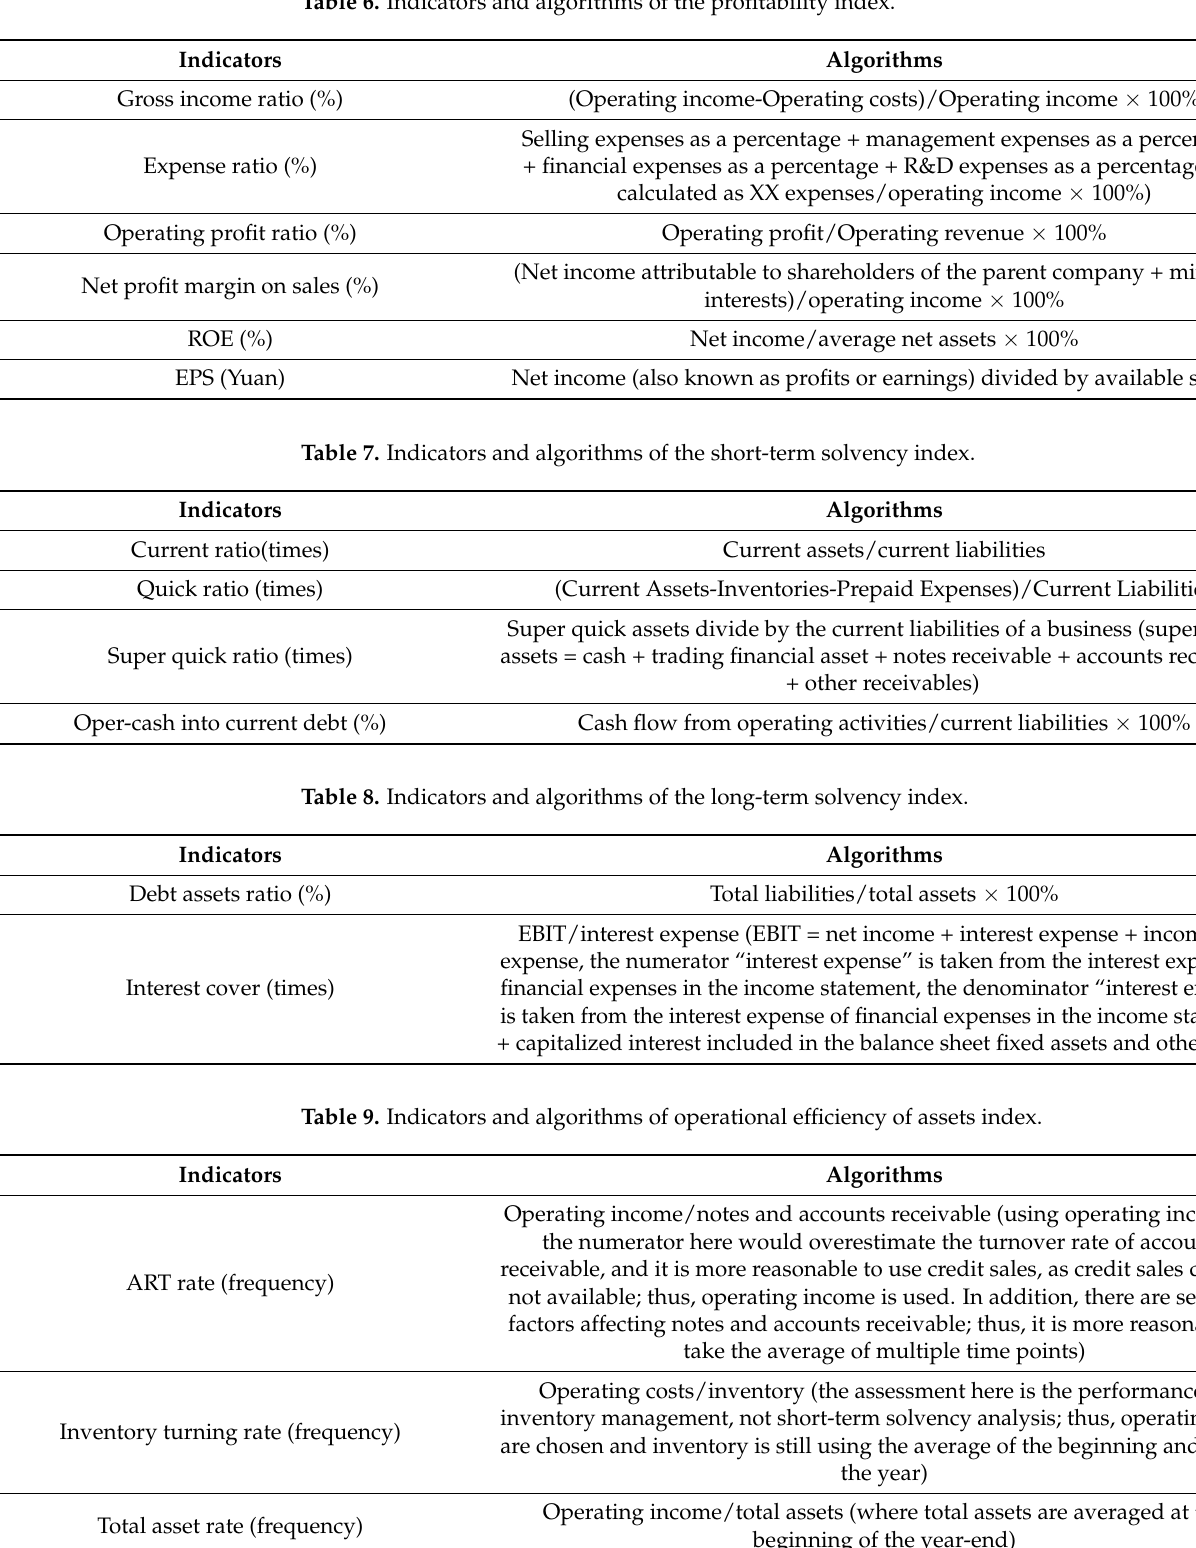
Table 6. Indicators and algorithms of the profitability index.